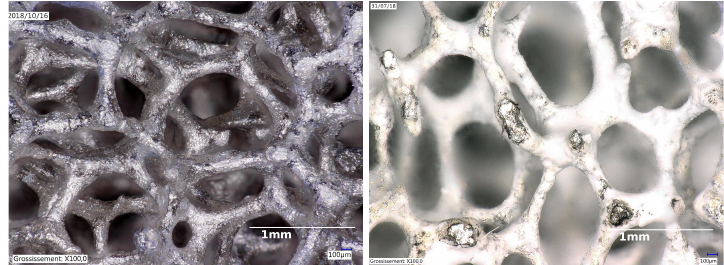
Figure 3. Macro photographs of an aluminum foam. ( Left ): pristine foam; ( Right ): foam coated with an alumina